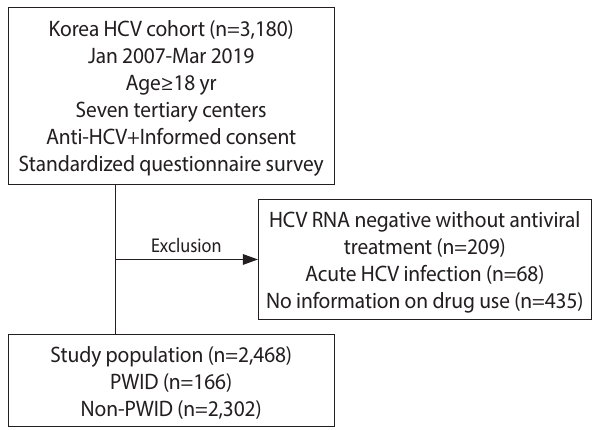
Figure 1. Study population. HCV, hepatitis C virus; PWID, people who